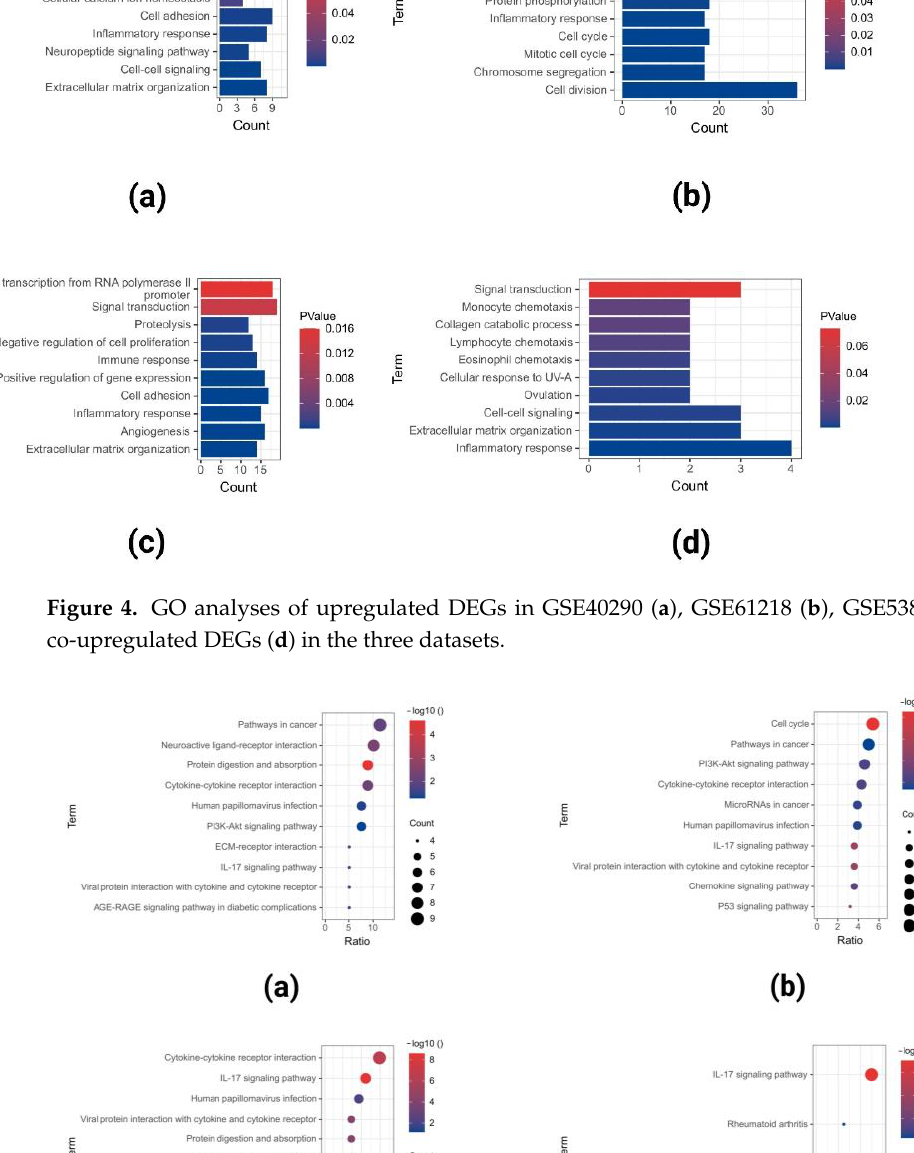
Figure 4. GO analyses of upregulated DEGs in GSE40290 ( a ), GSE61218 ( b ), GSE53819 ( c ), and co- upregulated DEGs ( d ) in the three datasets.